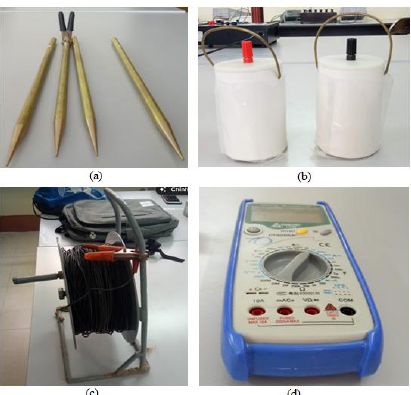
Figure 4: Equipment used for the SP measurement: (a) copper stake electrodes; (b) electrodes of Cu/CuSO4 porous pots; (c) wire reel; (d) multimeter.